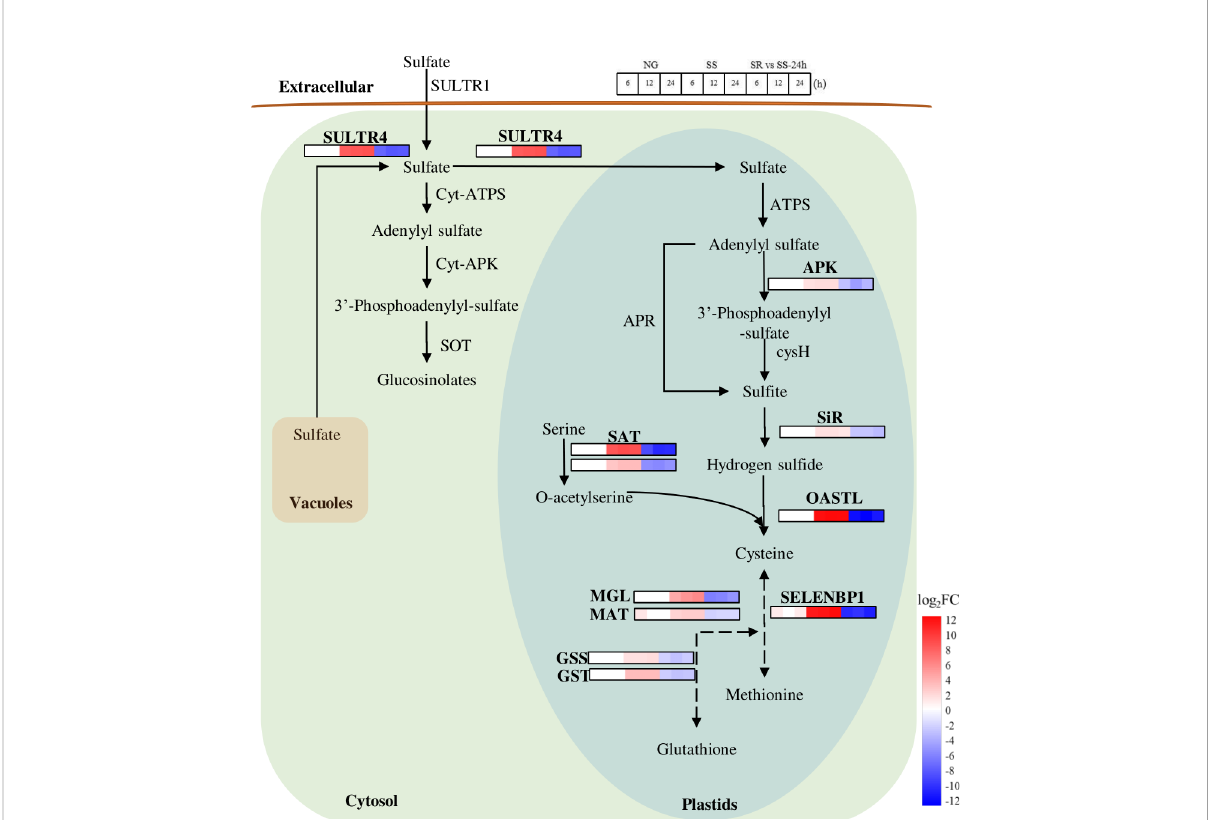
FIGURE 7 Expression patterns of identi fi ed SRV-DEGs in sulfate metabolic pathway of C. sorokiniana. SULTR4, sulfate transporter 4; ATPS, ATP sulfurylase; APK, adenylyl sulfate kinase; cysH, phosphoadenosine phosphosulfate reductase; APR, adenylyl-sulfate reductase; SiR, sul fi te reductase; OASTL, cysteine synthase[O-acetylserine(thiol)-lyase]; SELENBP1, methanethiol oxidase 1; SAT, acetyltransferase; MGL, methionine-gamma-lyase; MAT, Methionine aminotransferase; GSS, glutathione synthetase; GST, glutathione S-transferase; Cyt-ATPS, Cytosol ATP sulfurylase; Cyt-APK, Cytosol adenylyl sulfate kinase; SOT, sulfotransferases. Color legends are shown at the bottom right of the map. The time points of the genes ’ expression pattern are shown at the top right of the